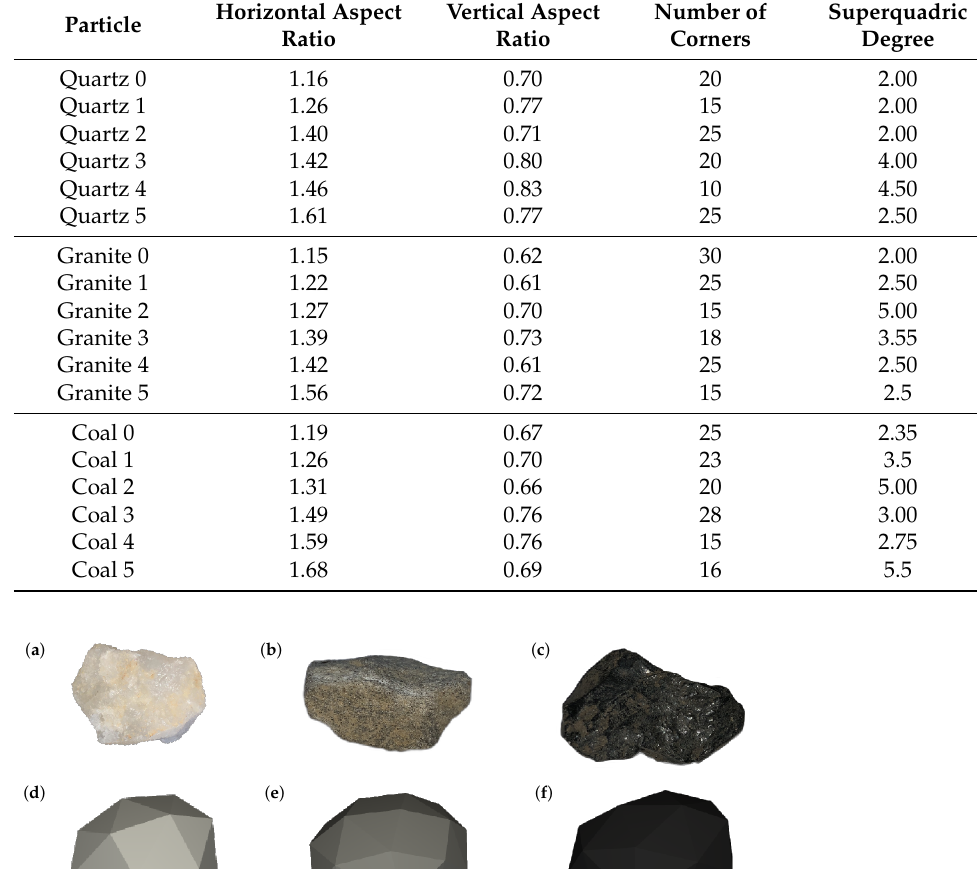
Table 4. Shape parameters of polyhedral particles. Aspect ratios, number of corners and superquadric degree of each modeled particle. For each material sample, 6 different shapes are selected.